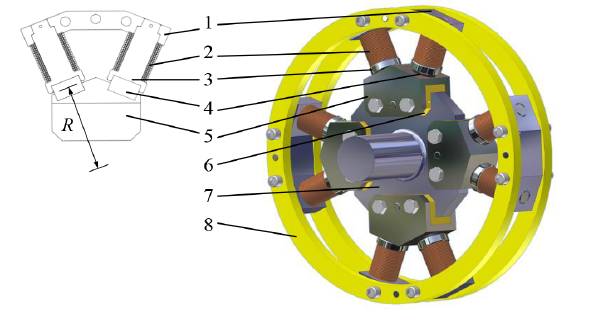
Figure 3. Dynamic amplification factors with different absorber damping factors.